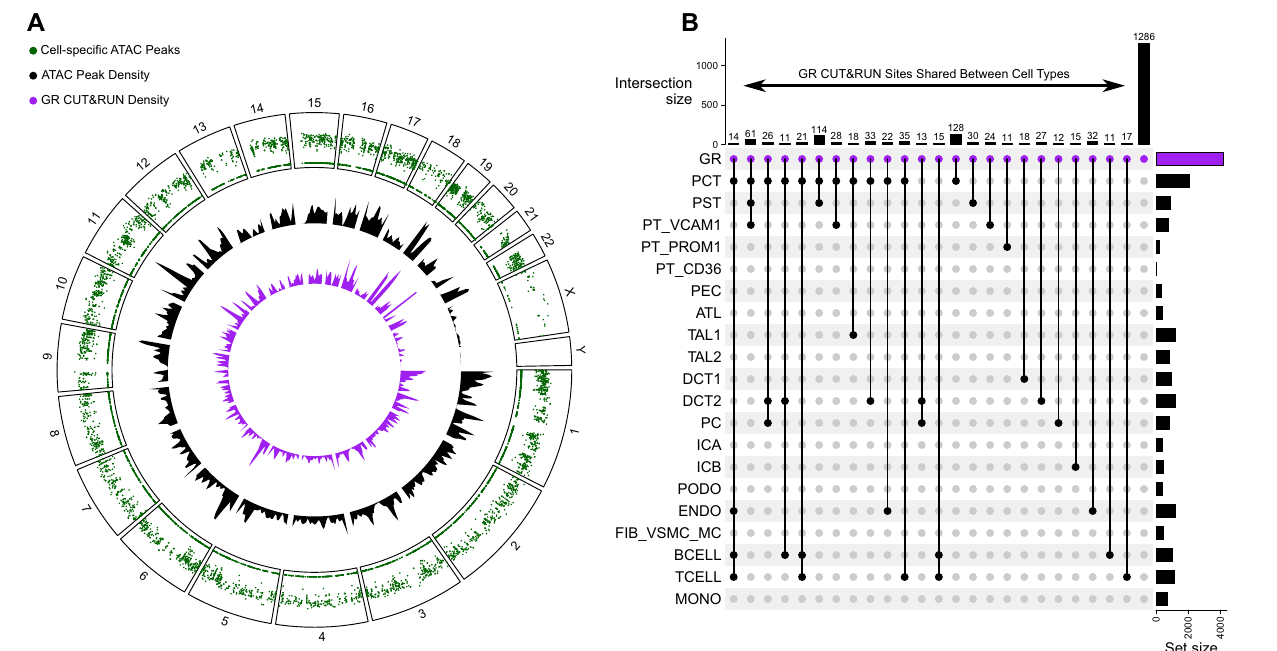
Fig.4|Glucocorticoidreceptor(GR)CUT&RUNinbulkkidneycortex.A Density ofGRCUT&RUNsitesrelativetocell-speci fi cATACpeaks.Cell-speci fi cATACpeaks cell-speci fi c ATAC peaks (black track) and GR CUT&RUN peaks (purple track) are shownadjacent to the rainfallplot using a 10Mbdefaultwindowsize. B Upset plot showing intersection between GR CUT&RUN sites and cell-speci fi c ATAC peaks. Each column of the Upset plot indicates a unique grouping of ATAC peaks that